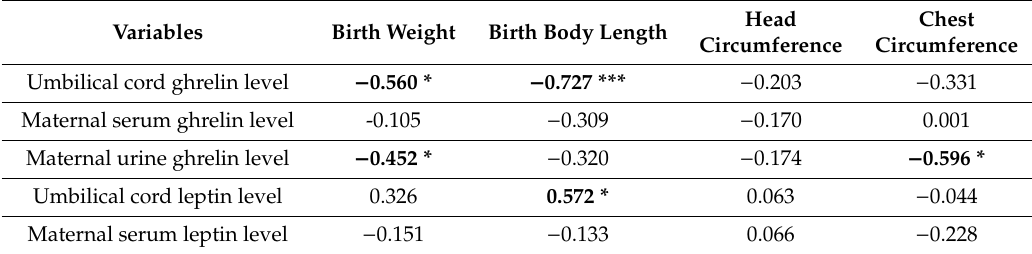
Table 2. Correlations of neonatal anthropometric measurements in the EGWG group (Spearman’s rho coe ffi